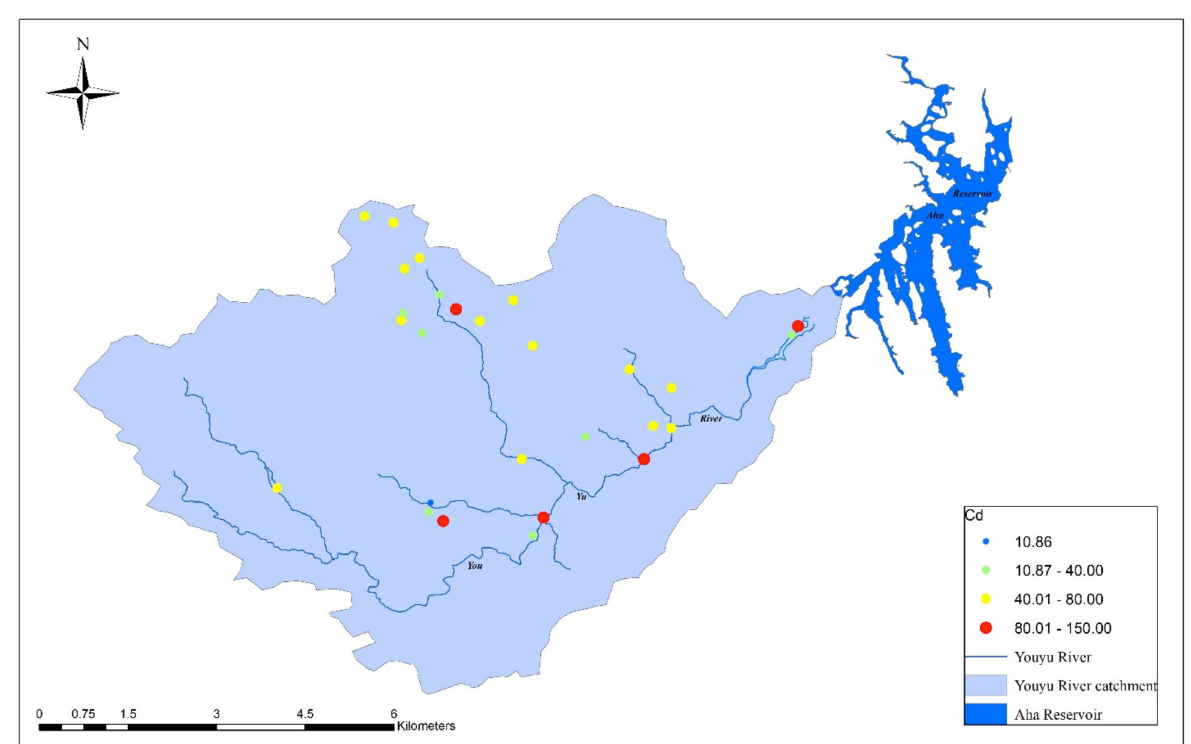
Figure 5. Spatial distribution of the potential ecological risks (E(i)) for Cd in the soil of the studied area.